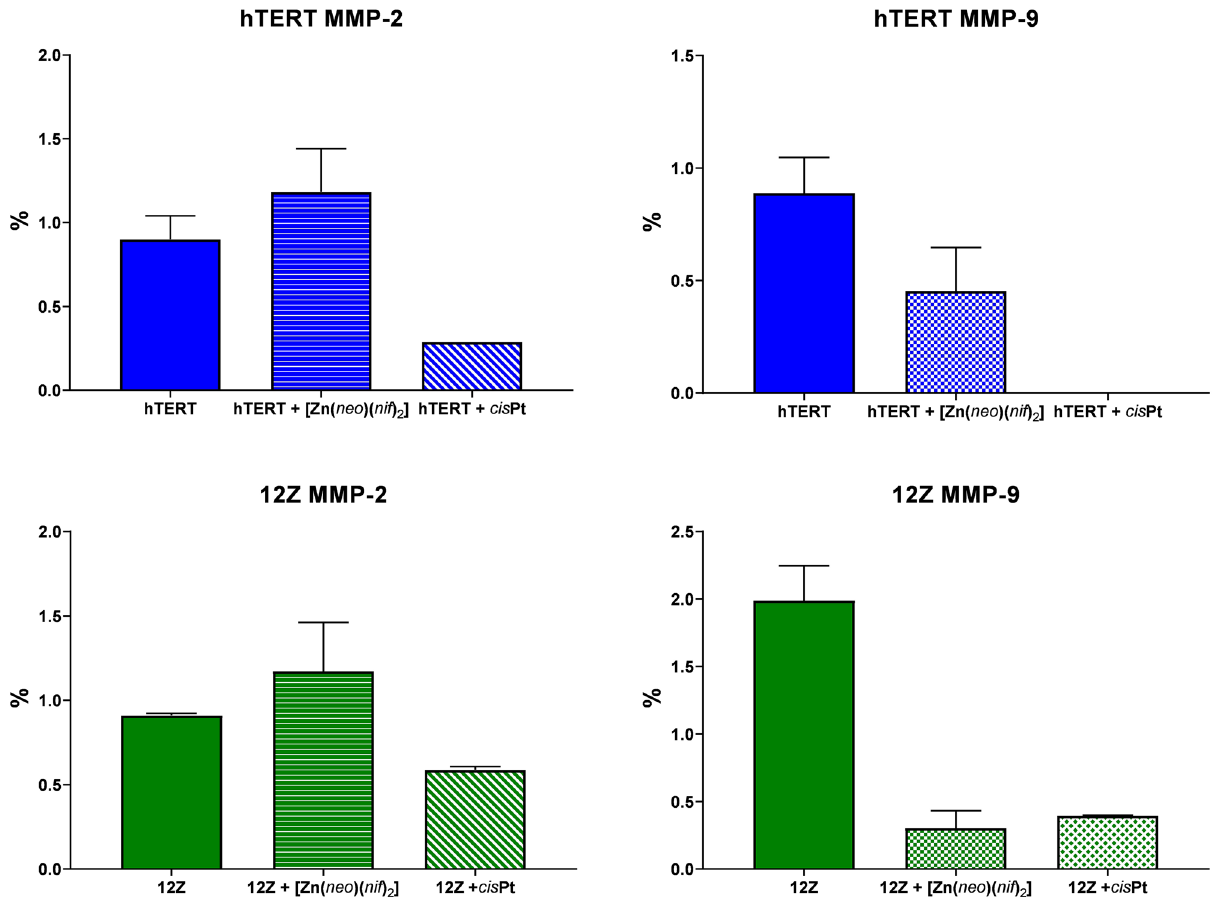
Figure 8. Total MMP-2/9 protein activity determined by gelatine Zymography in control (untreated cells hTERT or 12Z), cells treated with 10 µM [Zn( neo )( nif ) 2 ] or 10 µM cisPt for 24